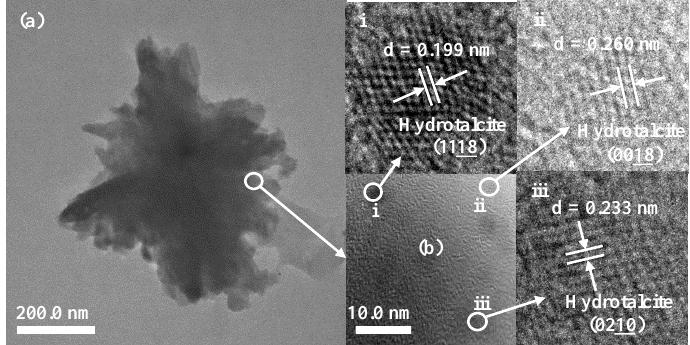
Figure 1. Transmission electron microscopy (TEM) ( a ) and high-resolution transmission electron microscopy (HRTEM) ( b ) photos of CuFe-LDH/N-CQDs.